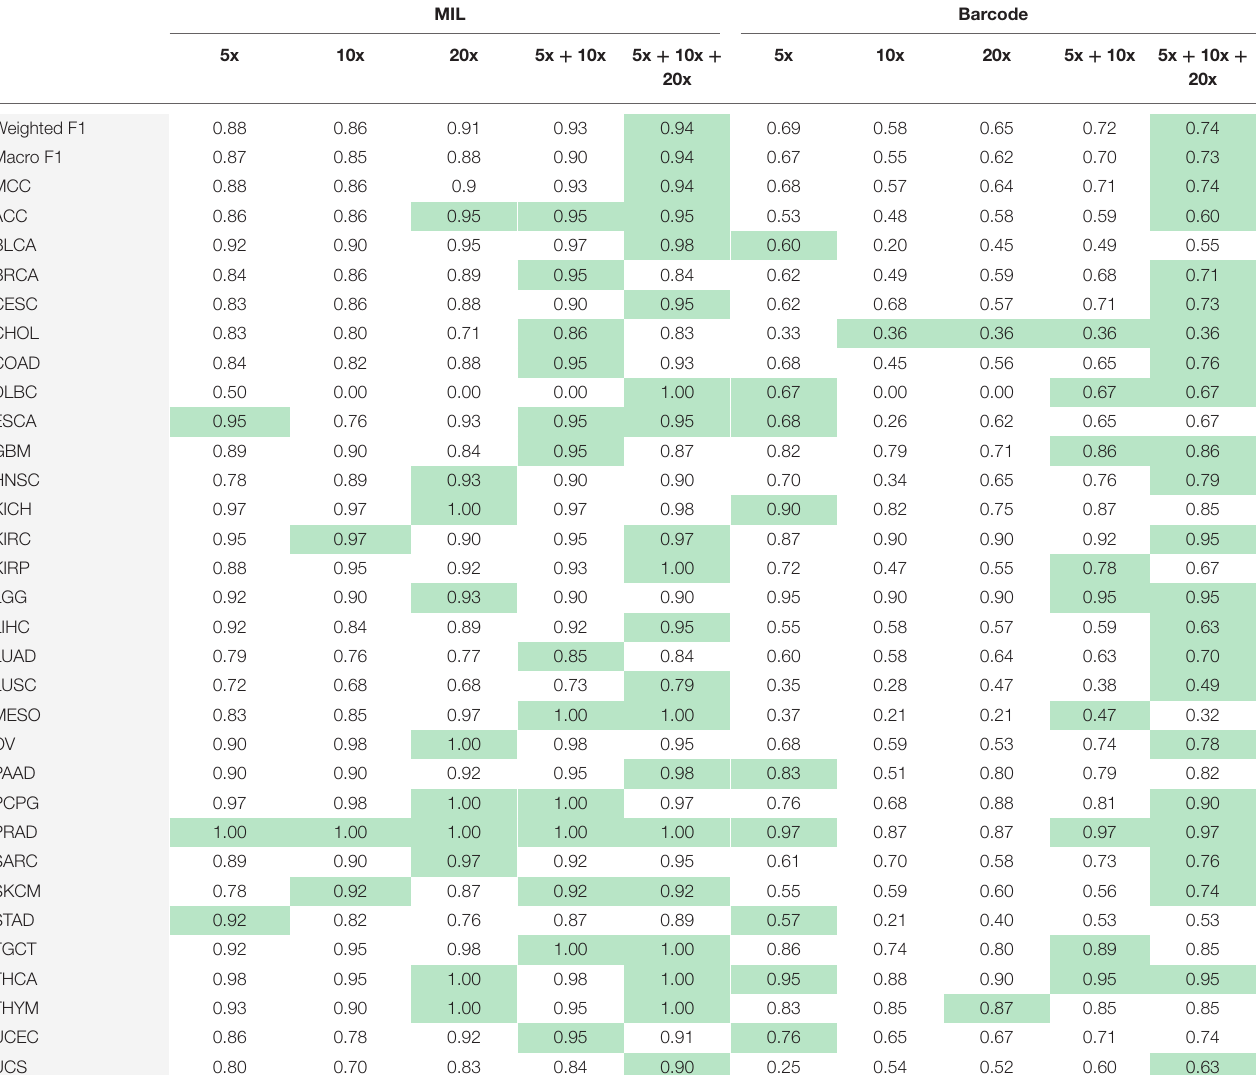
TABLE 3 | Results obtained performing MIL and the barcode analysis on single-scale and multi-scale